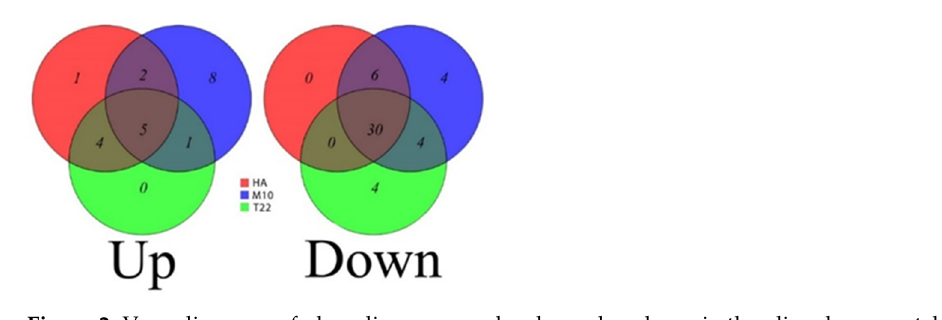
Figure 2. Venn diagrams of phenolic compounds whose abundance in the olive drupe metabolome is lower ( DOWN ) or higher ( UP ) compared to the control (CTRL). Samples treated with T22 are reported in green; with M10 in blue and with HA in red. Table 4. Metabolites identified in the drupe extracts of olive trees subjected to field applications of biological treatments. Samples are indicated by treatments with Trichoderma strains (TH1, GV41, T22, M10, and KV906) or secondary metabolites (HA and 6PP). Identifications were confirmed by comparing results with known compounds in an in-house database/standards and selecting matching ( ≥ 95%).